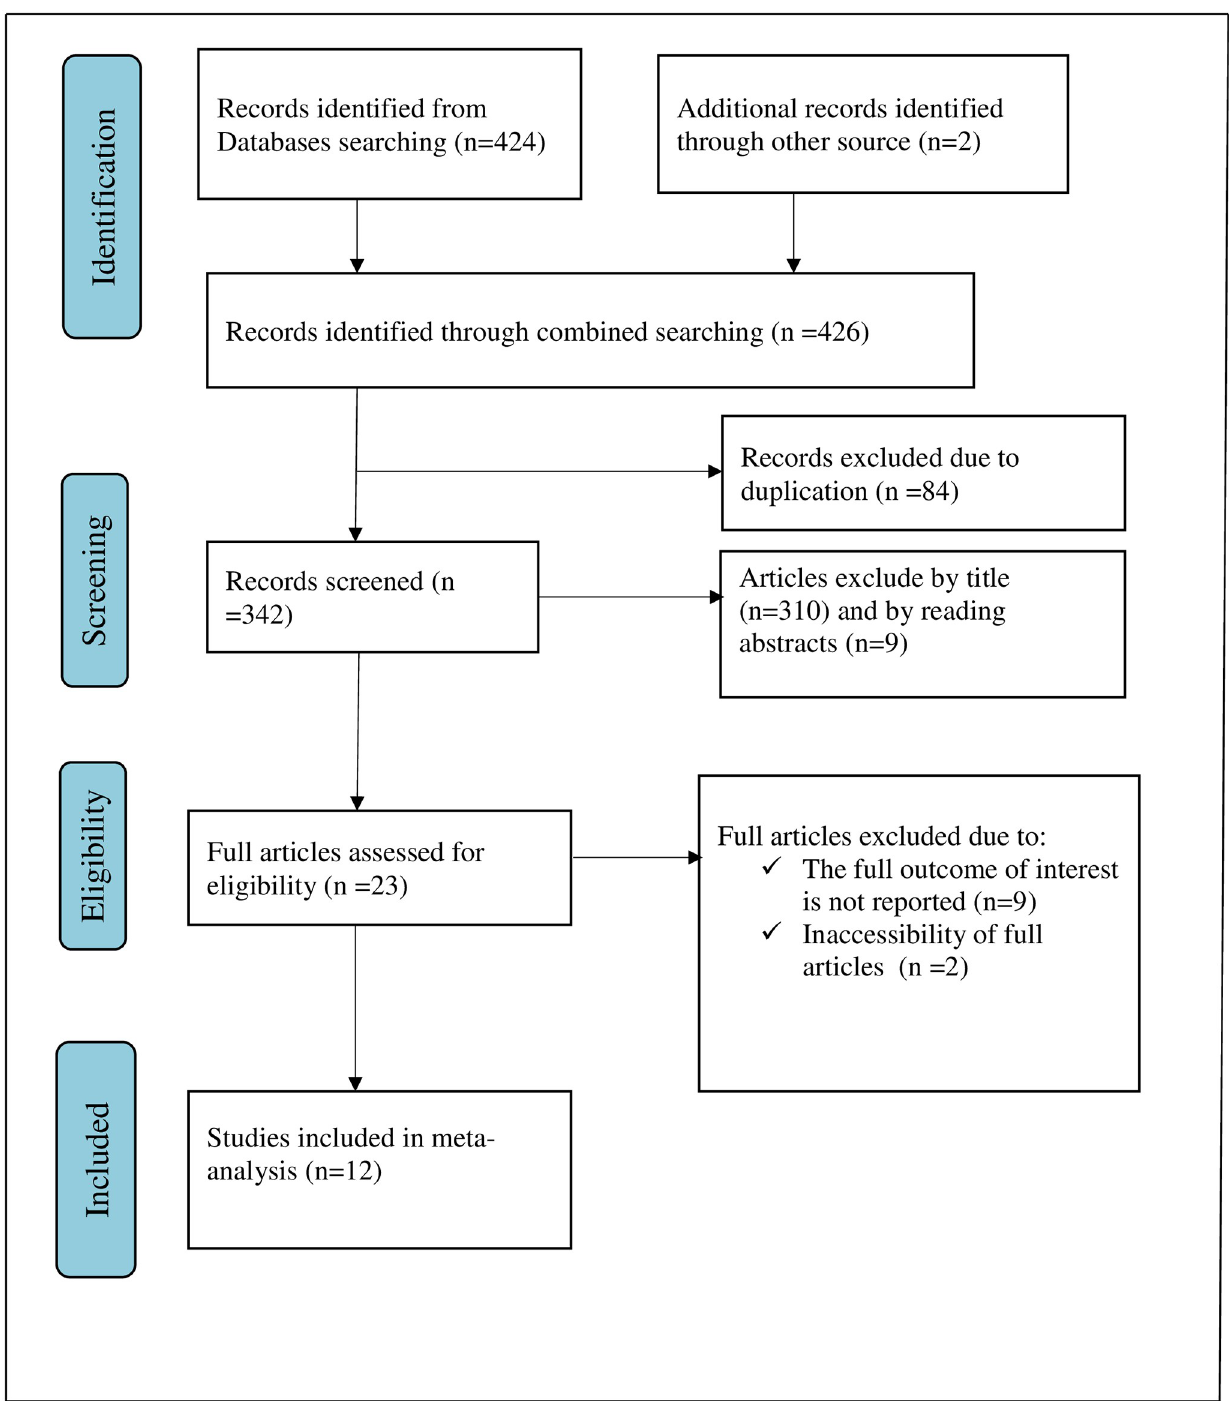
Fig 1. Flow chart of selection for systematic review and meta-analysis on COVID-19 vaccine acceptance and its determinant in Ethiopia, 2021.